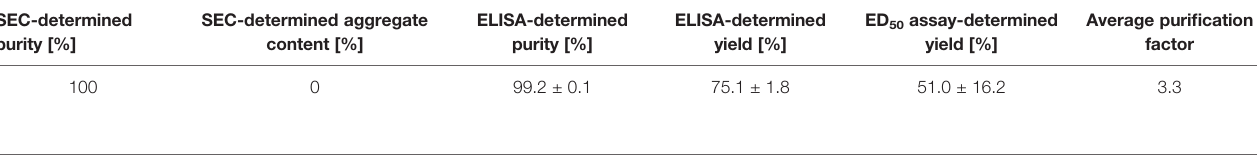
TABLE 3 | Final product ’ s properties. Results are given as a mean from eight experiments +/- 95% CI.